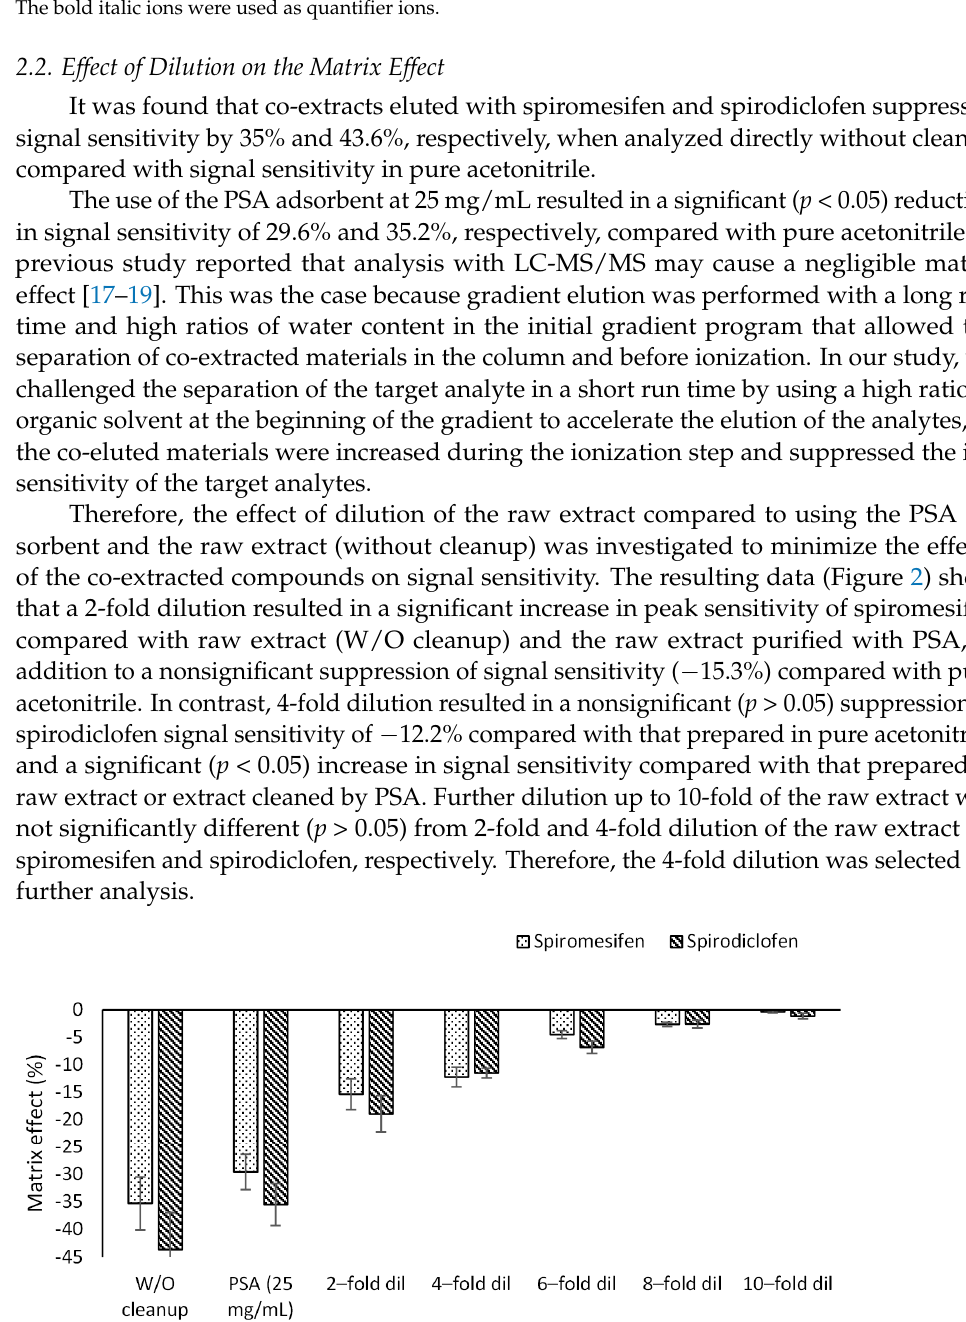
Figure 2. Effect of using PSA (25 mg/mL) vs. dilution (2–10 fold) on the matrix Figure 2. E ff ect of using PSA (25 mg/mL) vs. dilution (2–10 foldx) on the matrix e ff ect.